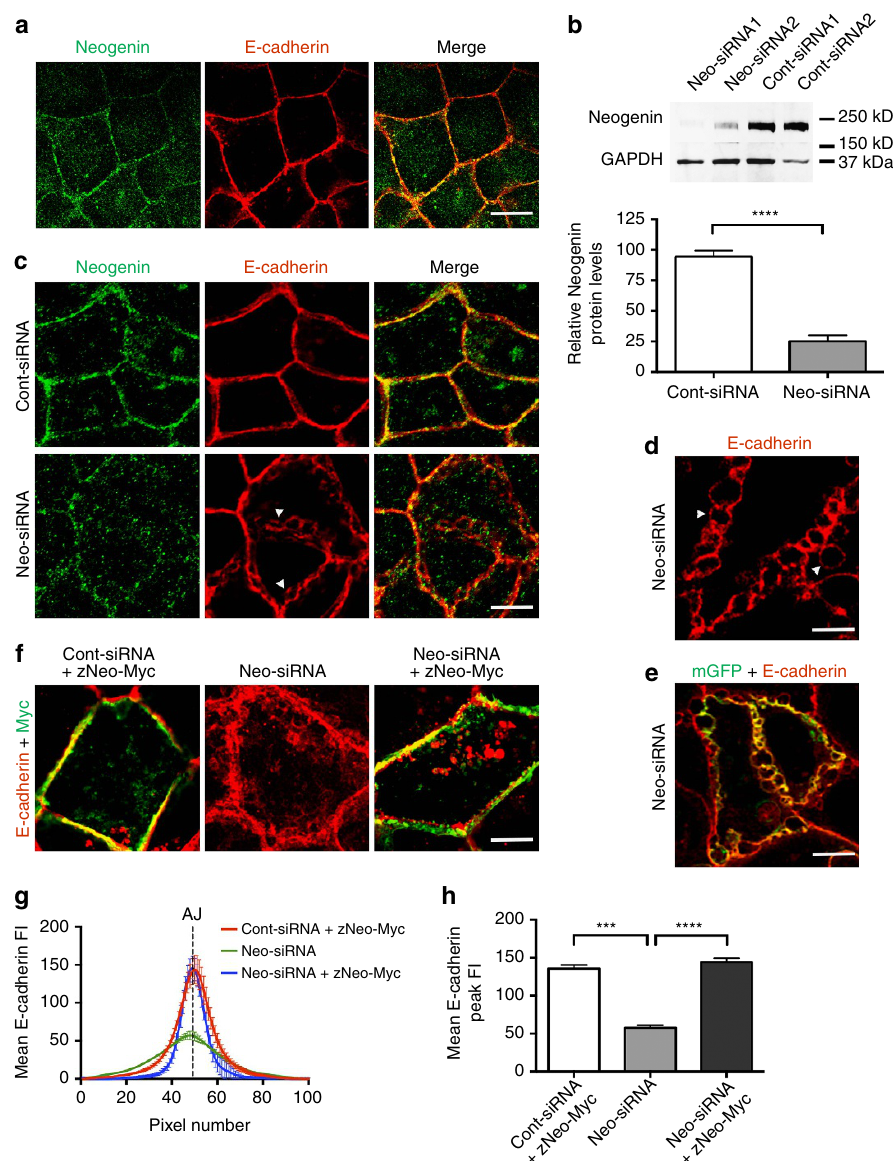
Figure 1 | Neogenin maintains AJ integrity. ( a ) Representative confocal micrograph showing apical view of Caco-2 cells where Neogenin (green) co-localized with Ecad (red; merge, yellow) at the AJ. ( b ) Immunoblot densitometry of Neogenin protein levels in Neo-siRNA cells relative to the control protein, GAPDH ( n ¼ 3, mean ± s.e.m., **** P o 0.0001, Student’s t -test). ( c ) Neo-siRNA induced the loss of adhesion between Ecad þ membranes, leading to the formation of tightly packed bleb-like structures at the AJ (arrowheads; Ecad, red; Neogenin, green). ( d ) Higher-magnification image of disrupted AJs in Neo-siRNA-expressing cells. ( e ) Co-localization of membrane-bound GFP (mGFP, green) and Ecad (red; merge, yellow) in Neo-siRNA-transfected cells. ( f ) Full-length zebrafish Neogenin (zNeo-Myc) rescued junctional integrity (Myc, green; Ecad, red). Line-scan analysis: ( g ) mean Ecad fluorescence intensity (FI) across AJs. ( h ) Mean Ecad peak FI at the AJ ( n ¼ 150 junctions, mean ± s.e.m., *** P o 0.001, **** P o 0.0001, one-way analysis of variance (ANOVA), Dunn’s post hoc test). Scale bars, 15 m m ( a , c ); 5 m m ( d , e ); 7 m m ( f ). 15–30 min and a 3.4-fold reduction in the initial rate of Ecad internalization (Fig. 2i,j), indicating that Neogenin was required for Ecad endocytosis. All internalization was prevented in the presence of chlorpromazine, which can inhibit clathrin-mediated endocytosis (Supplementary Fig. 2b). Therefore, suppression of Ecad recycling within the junctional membrane may contribute, at last in part, to the junctional defect in Neo-siRNA cells.